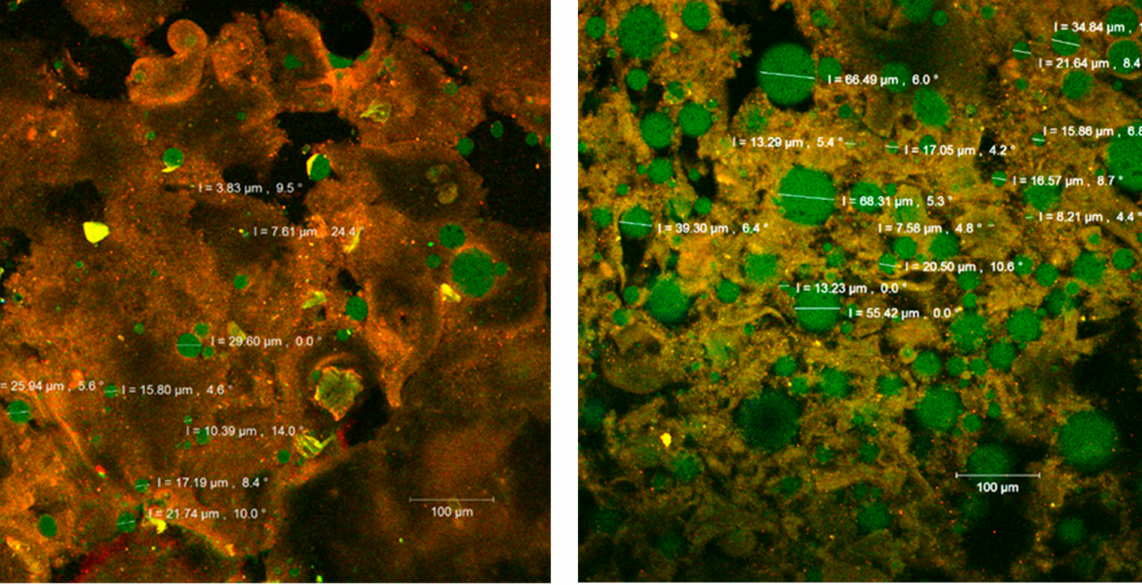
Figure 4. The confocal laser scanning microscopy (CLSM) images of the fluorophore dyed powders. The confocal analysis of the samples after the fluorescent staining with Red Congo revealed the biologically active compounds from sea buckthorn fruit extracts in the form of spherosomes (in green) with different diameters between 3.83 and 215.78 µ m. The Congo red dye binds the intact β -d-glucans from the biopolymer matrices [27] as well as the peptides from the WPI, marking them in orange (Figure 4). Small spherosomes (<25 µ m) are visualized in P1, while in P2 they are of medium size. P2 displayed a large number of spherosomes of medium size, well individualized, with a tendency to group in clusters and well stabilized in the WPI and CMC matrix. Similar results were previously obtained by Mihalcea et al. [15], who use WPI and acacia gum as the encapsulation material, and by Neagu et al. [21], who compared the native sea buckthorn extract with the cross-linked one mediated by